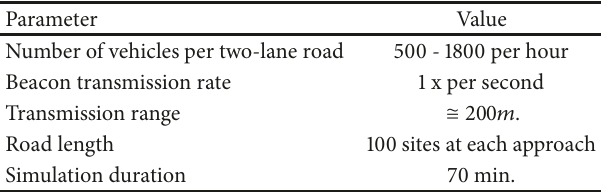
Table 1: The simulation parameters for waiting times. Parameter Value Number of vehicles per two-lane road 500 - 1800 per hour Beacon transmission rate 1 x per second Transmission range ≅ 200𝑚. Road length 100 sites at each approach Simulation duration 70 min.